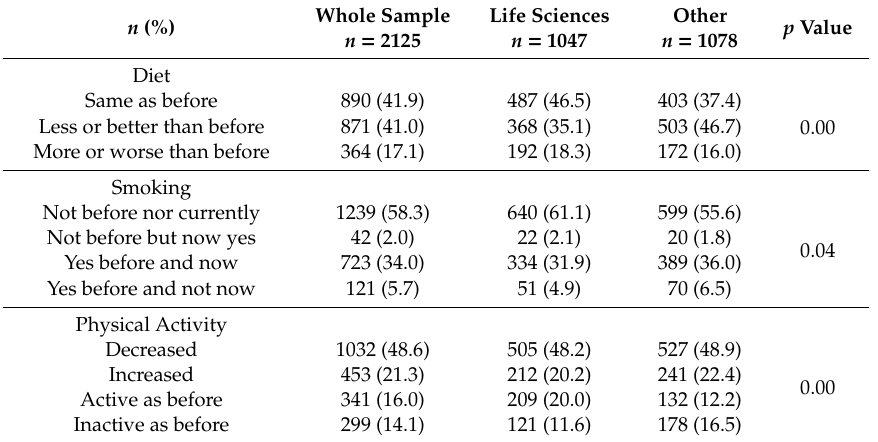
Table 3. Answers provided by students from the two groups about their behaviors during the lockdown.